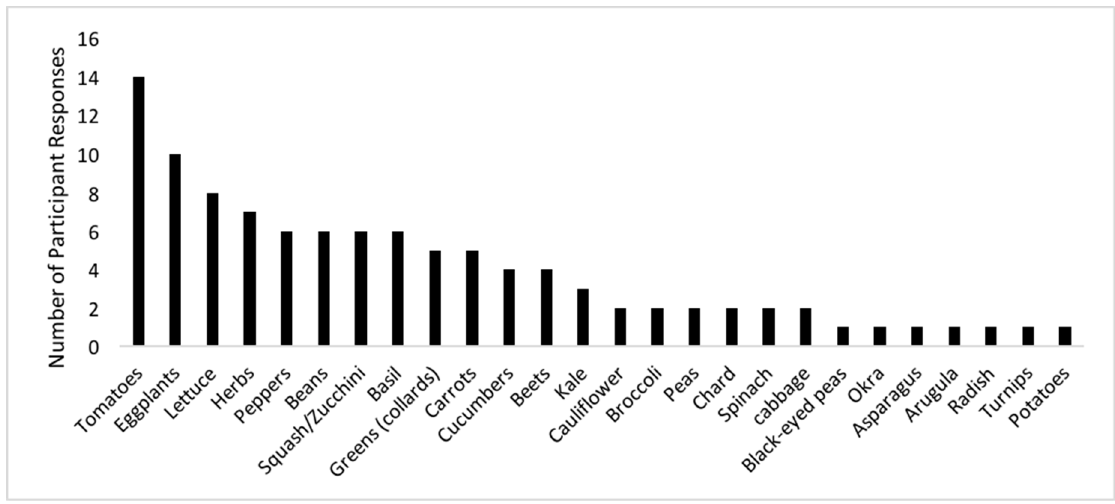
Figure 3. Crops typically grown by participants.